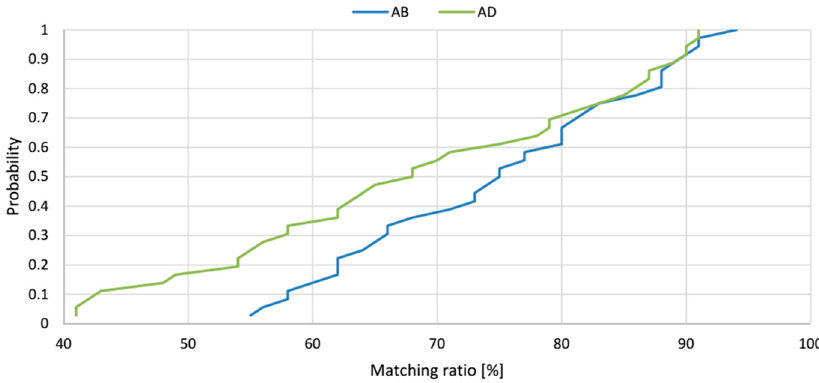
Figure 17. The example of theoretical solid with a number of experimental location estimates outside the solid (red dots). Figure 18. The cumulative distribution functions of the matching ratios for AB and AD pairs.